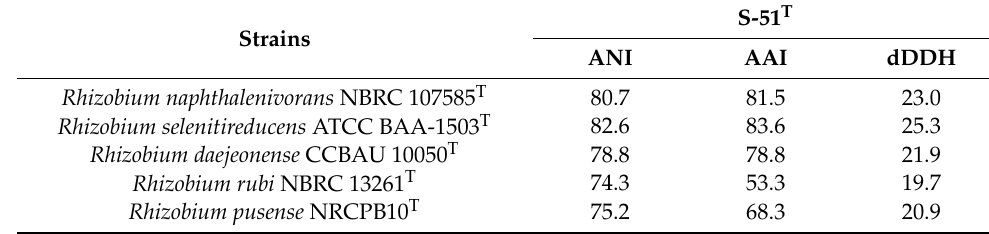
Table 2. ANI, AAI, and dDDH values (%) of strain S-51 T and other members of the genus Rhizobium .